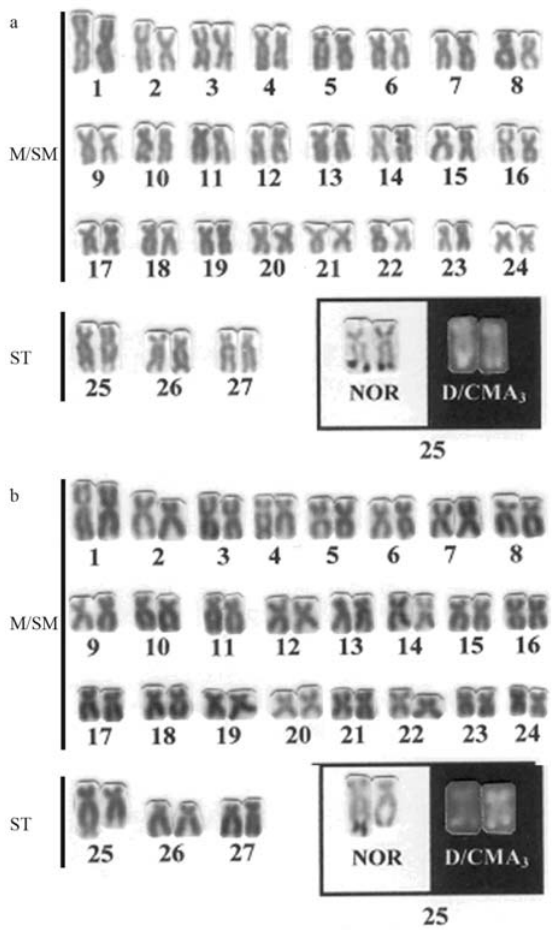
Figure1 -Karyotypesof:a. Parodontortuosus andb. Parodonnasus with conventionalGiemsastaining.Thenucleolarorganizerregionsaftersilver nitrate (Ag-NOR) and D/CMA 3 staining are showed in the